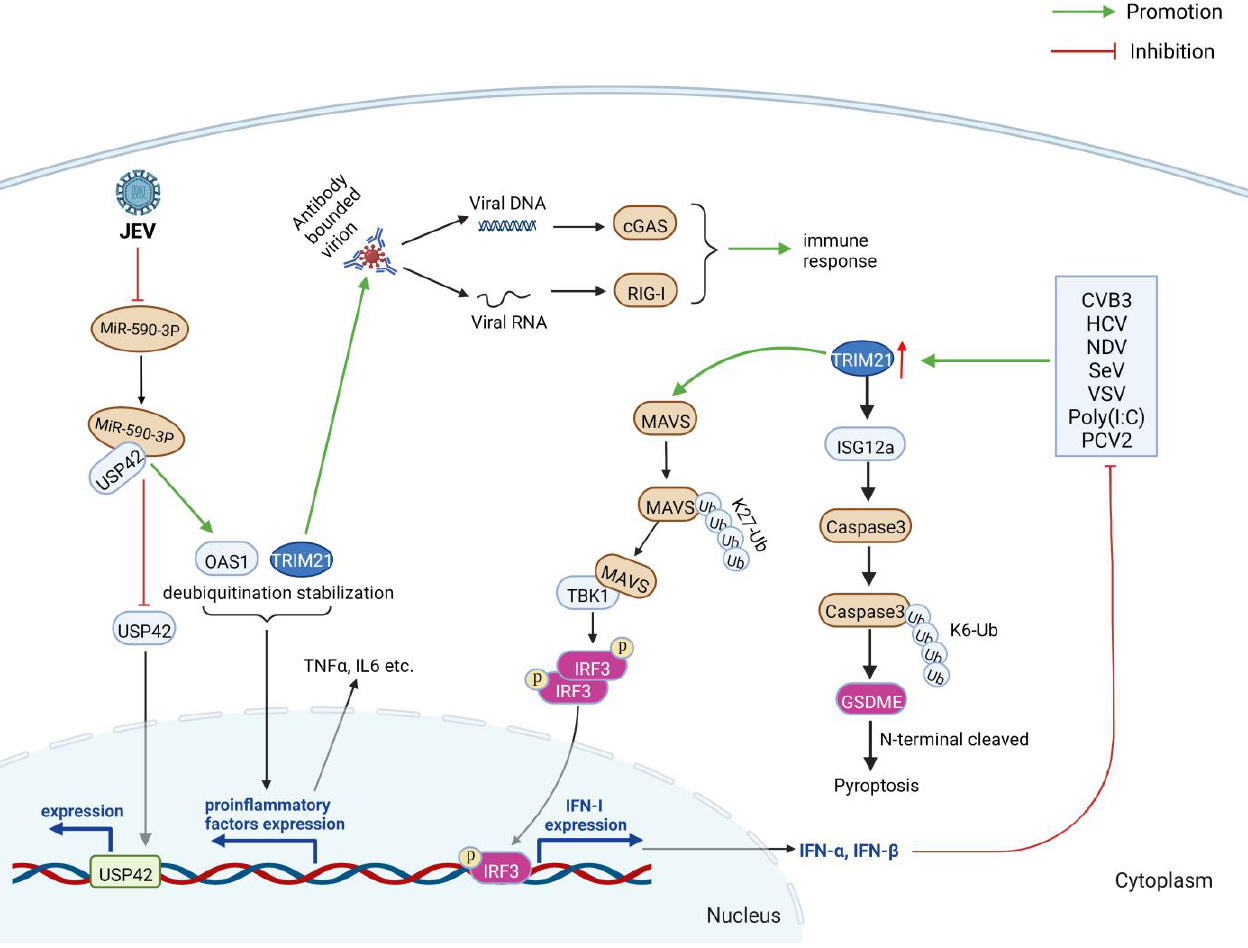
Figure 7. TRIM21 positively influences host immune responses during virus infection. TRIM21 has diverse activities during different virus infections, and its regulation of type I IFN and inflammatory responses are inconsistent during various virus infections. Figure created with BioRender.com.